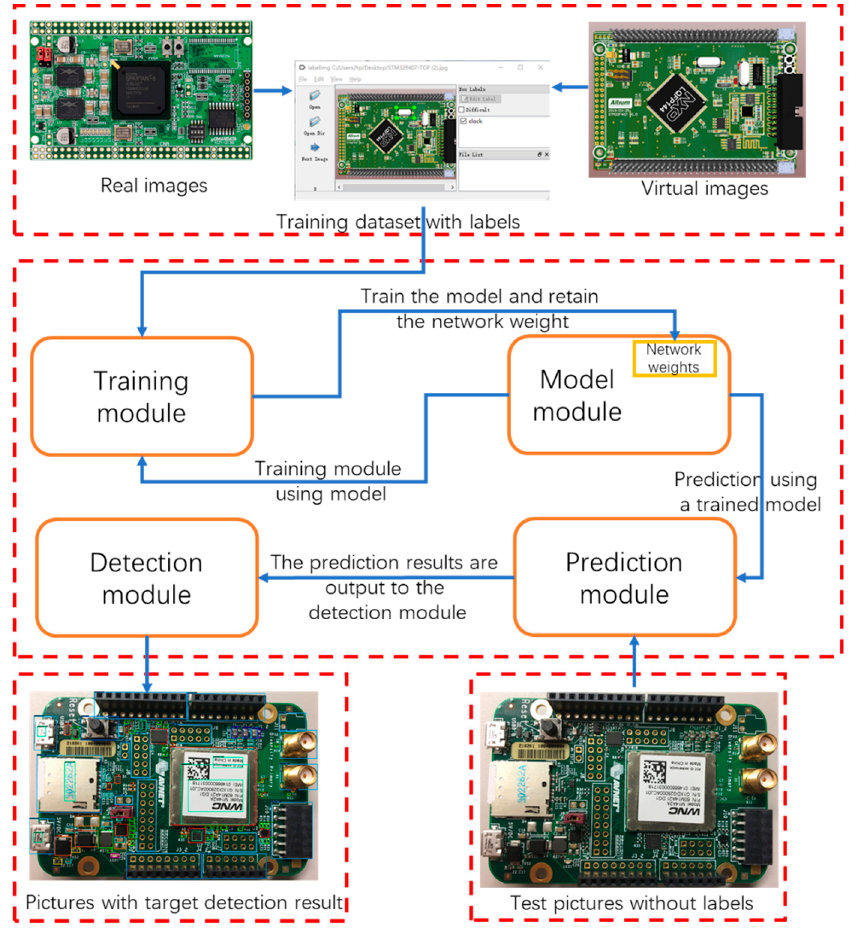
Figure 1. Technical flowchart of the study.